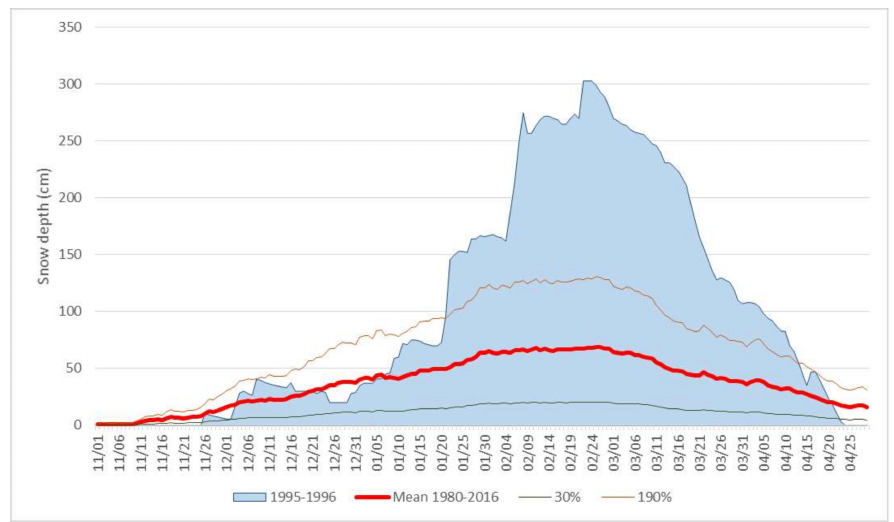
Figure 4. Blue polygon shows the daily snow depth (cm) data recorded at the manual weather station in Arinsal ski resort (1927 m a.s.l.) during the winter season, from 1st November 1995 to 30th April 1996. Red, green and brown lines correspond, respectively, to the mean, 30% and 190% values of snow depth (cm) for the 1980–2016 reference period. Gaps in the long-term daily snow depth series have been reconstructed by means of the Safran–Crocus reanalyses generated within the framework of the CLIMPY 2016-2019 project.